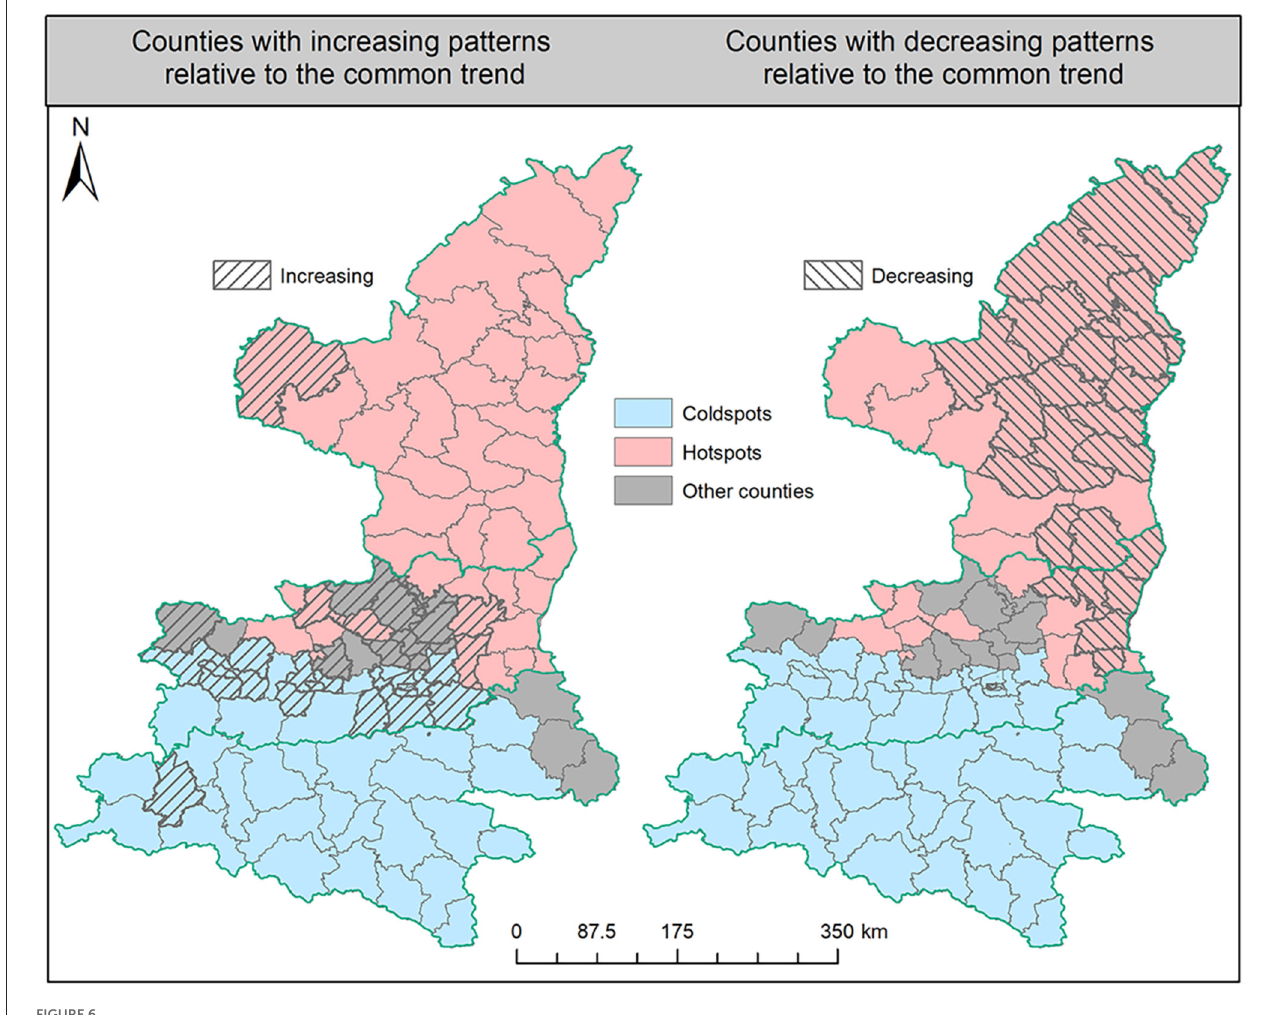
FIGURE6 Hot spots and cold spots with different temporal